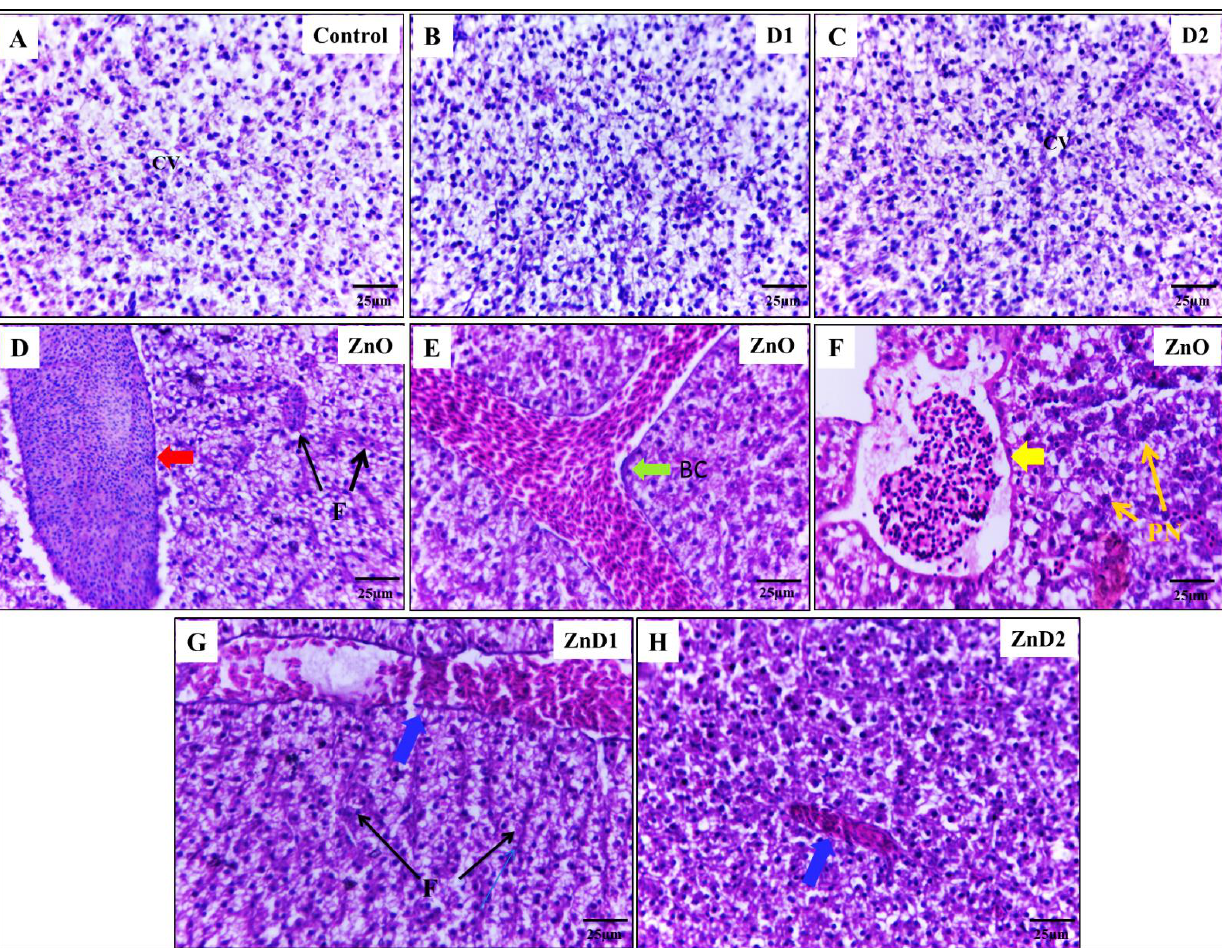
Figure 4. ZnO-NPs induced hepatic histopathological changes in the male Zebrafish: ( A ) Representative photomicrographs showing normal histology of hepatocytes and central vein; ( B ) photomicrograph of D1 group liver showing normal hepatic architecture; ( C ) photomicrographs of D2 group liver showing normal hepatocytes and central vein; ( D ) – ( F ) representative photomicrographs of the ZnO-NPs group showing different histopathological observations including inflammation (Red arrow), fibrosis (Black arrow), hemorrhagic appearance with dilation of hepatic bile ducts (Green arrow), Pyknosis (Orange arrow), and Necrosis (Yellow arrow); ( G ) representative photomicrograph of ZnD1 liver showing gradual disappearance of hemorrhagic appearance (Blue arrow) despite the presence of fibrosis (Black arrow); ( H ) representative photomicrograph of ZnD2 liver showing the ameliorative effect of D. salina in restoring the liver architecture, relieving hepatic inflammation and hemorrhagic appearance (Blue arrow). Scale magnification is shown in pictures. CV: Central Vein, F: Fibrosis, PN: Pyknotic Nuclei.